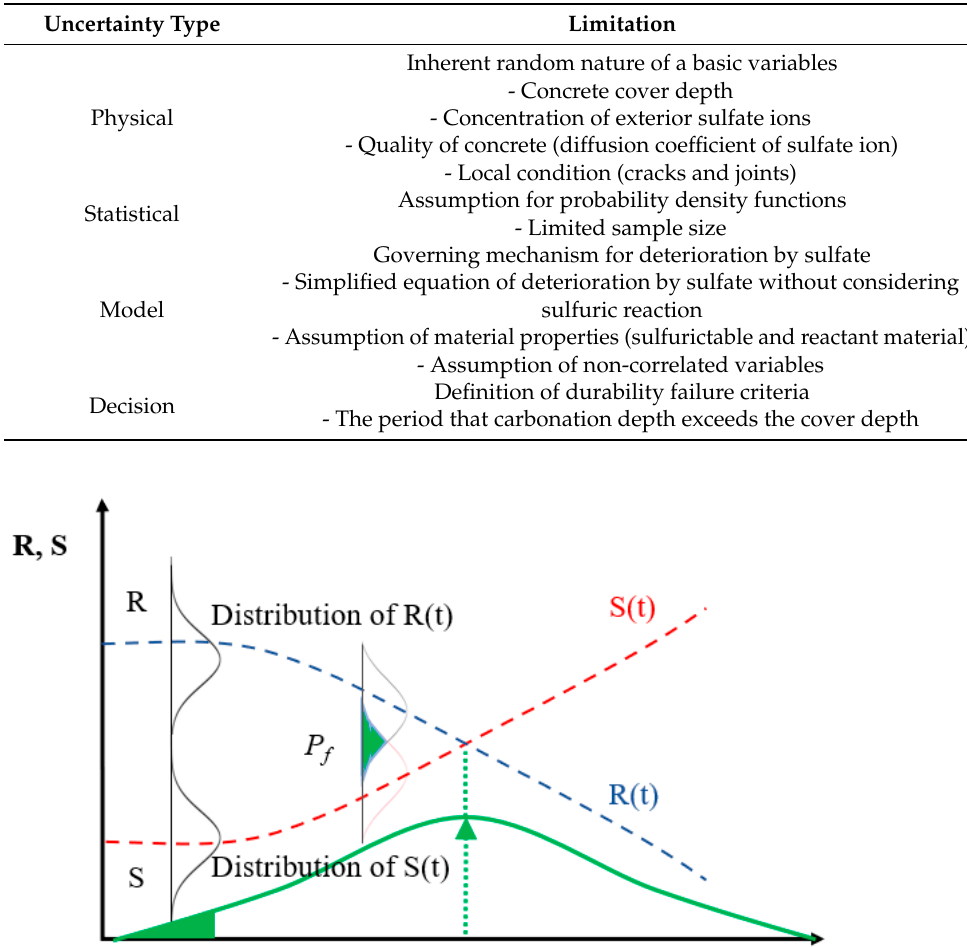
Table 1. Engineering uncertainties in durability design.